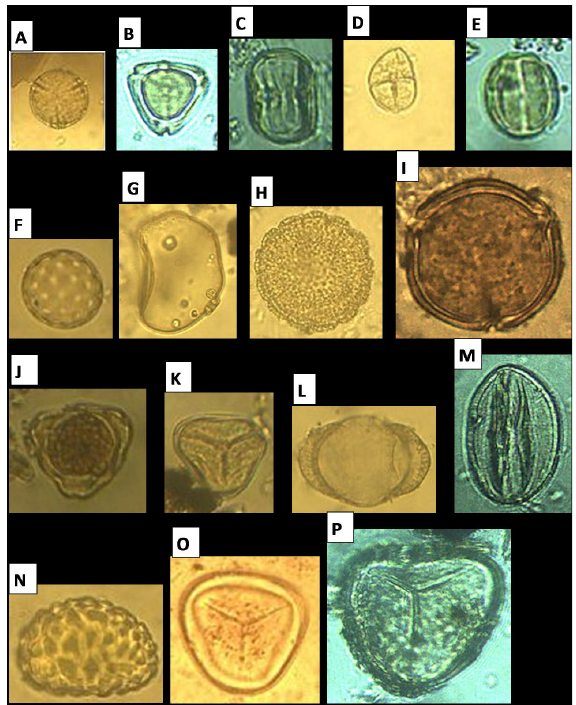
Fig. 3. Photomicrographs of some recovered pollen grains and fern spores in this study (A-M: Pollen grains; N-P: Fern spores);